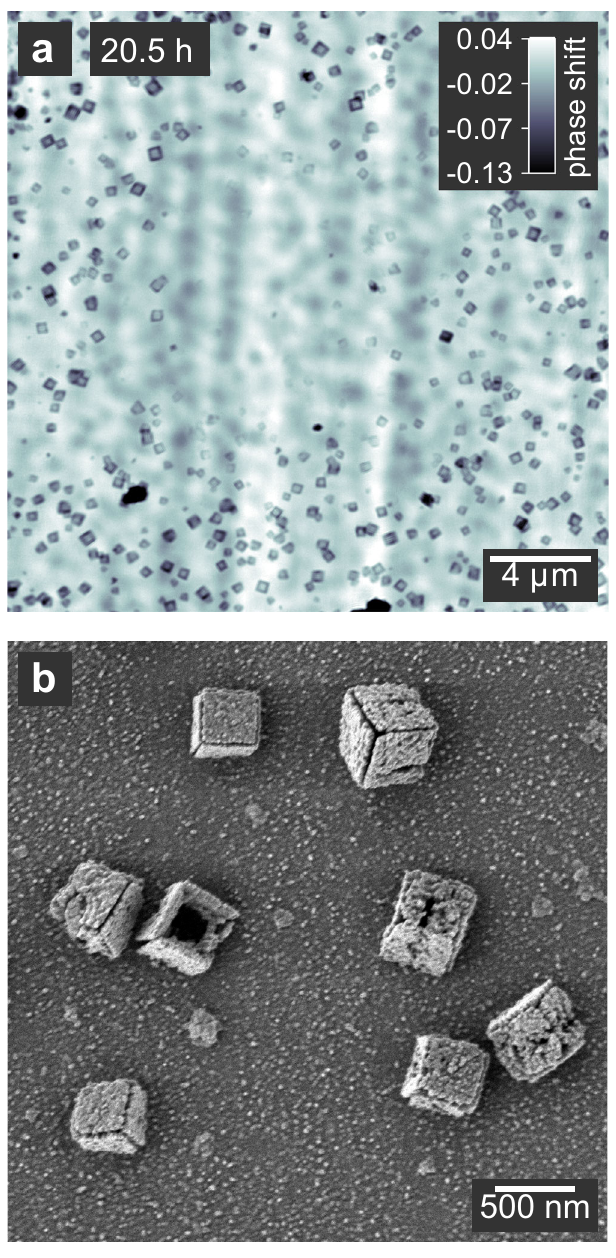
Fig.6|Beam-induceddamagetothenanocuboids.a Ptychographicimagetaken after20.5hwithanextended fi eldofviewaroundtheregionthatwascontinuously exposed forinsitu imaging. The beam-induced disintegration of particles isvisible in the exposed region in the middle. The image shows an overlay of particles on both reactor windows since multi-slicing could not be applied due to the decreasing distancebetween the windows. The grayscale indicates the phase shift oftheimageinradian. b SEMimageofparticlesfromthesamesampleasin a ,taken close to the exposed region. The nanocuboids show the onset of disintegration at the